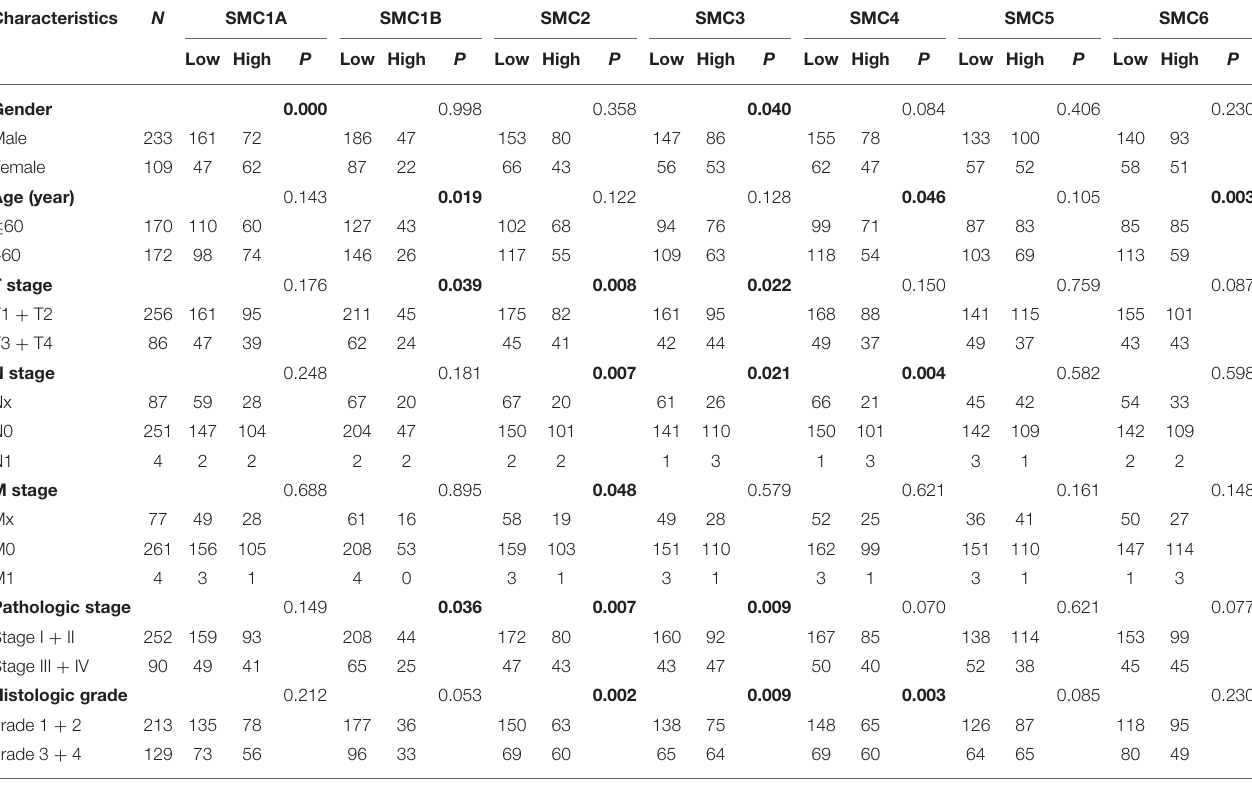
TABLE 1 | Clinicopathologic parameters and the expression of SMC family members in HCC.